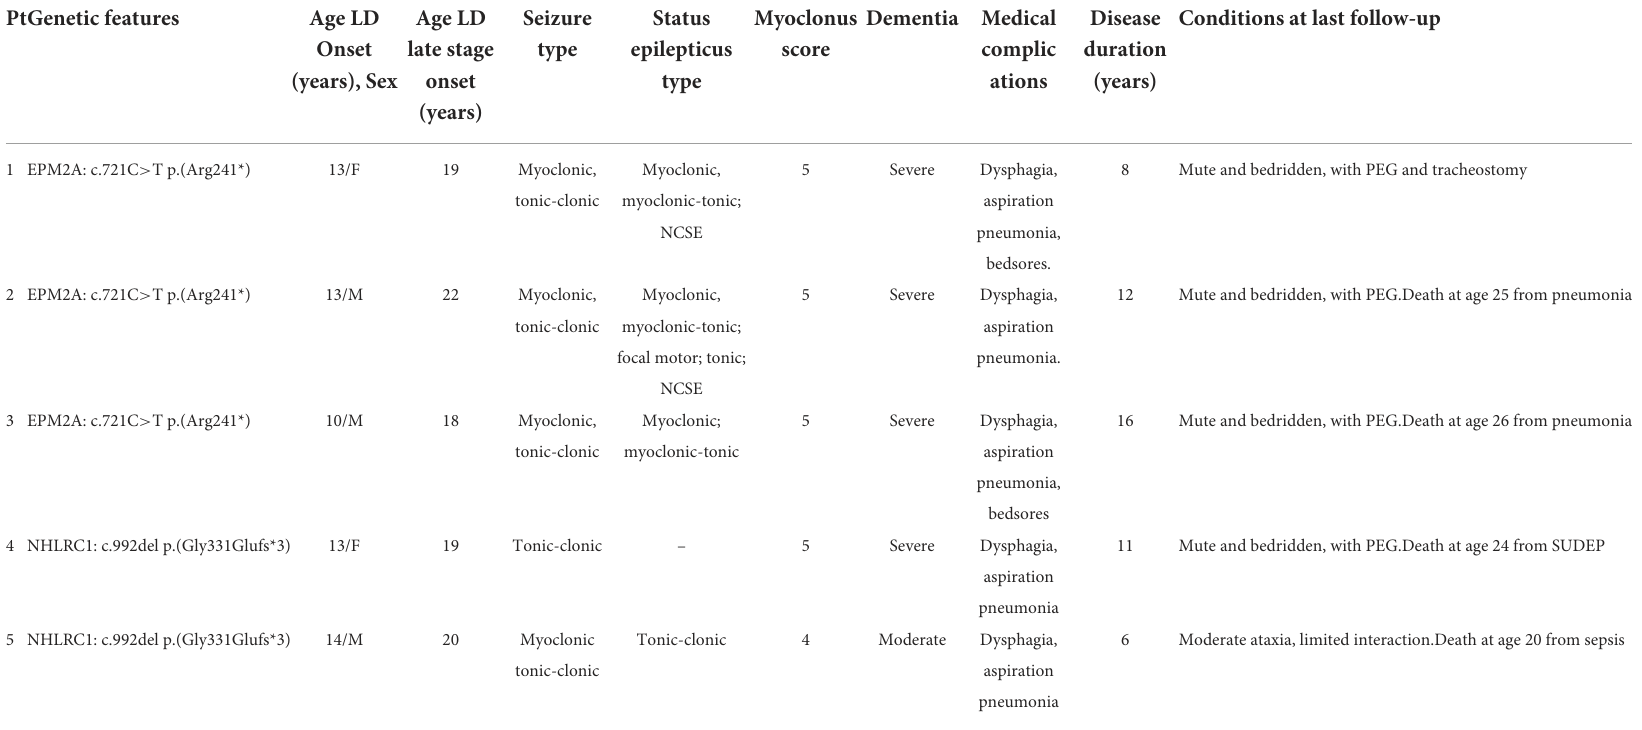
TABLE 1 Clinical features of the late stage of Lafora disease. PtGenetic